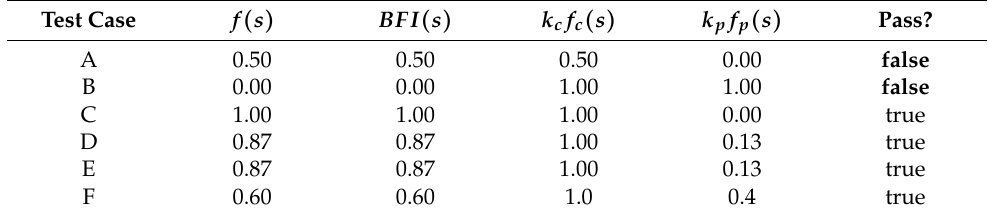
Table 4. Robustness results for k c = 1.0, k p = 1.0.